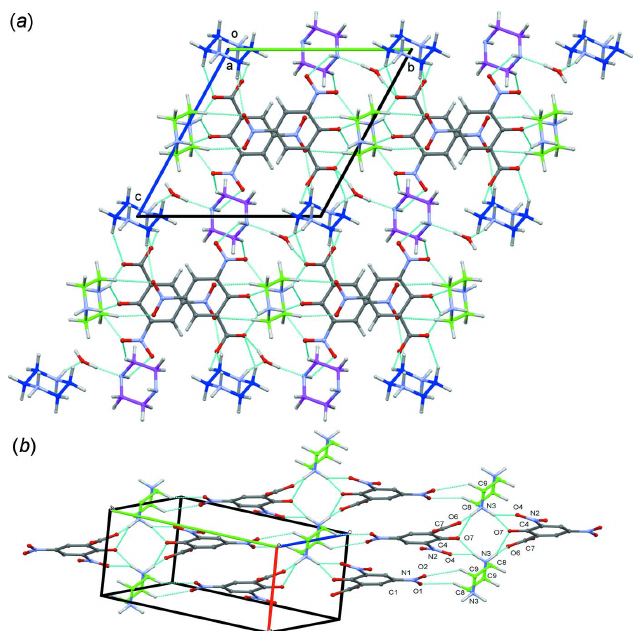
Figure 5 Crystal packing of (I), ( a ) viewed along the a axis and ( b ) viewed along the c axis.